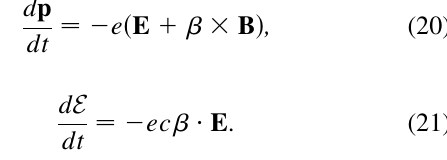
FIG. 5. Contour plots of the E of the polarization plane. These are snapshots corresponding to !t (cid:3) 0 and for field parameters the same as in Fig.